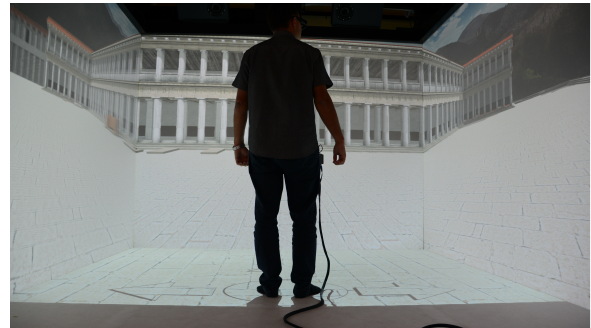
Figure 2. 3D model of the agora within the CAVE